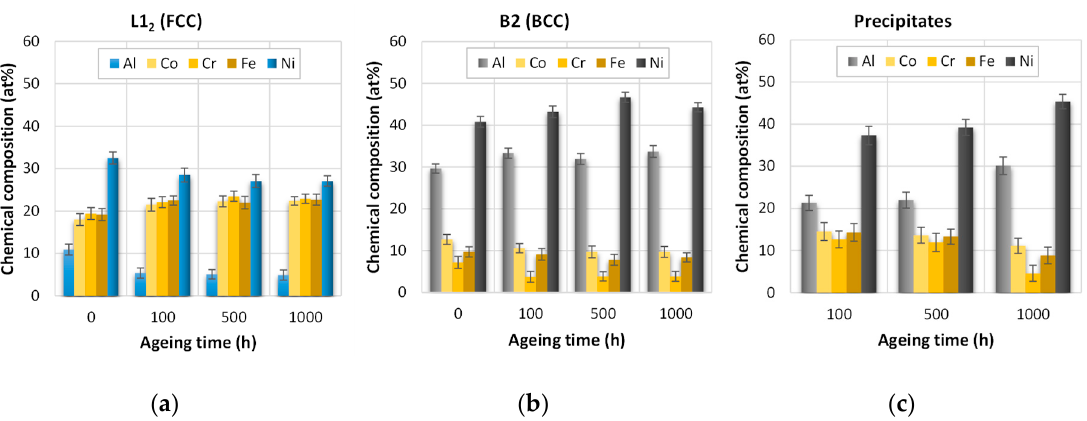
Figure 4. Changes of elemental concentration in at% with aging at 800 °C in: ( a ) L1 2 (FCC) phase; ( b ) B2 (BCC) phase; ( c ) Precipitates.